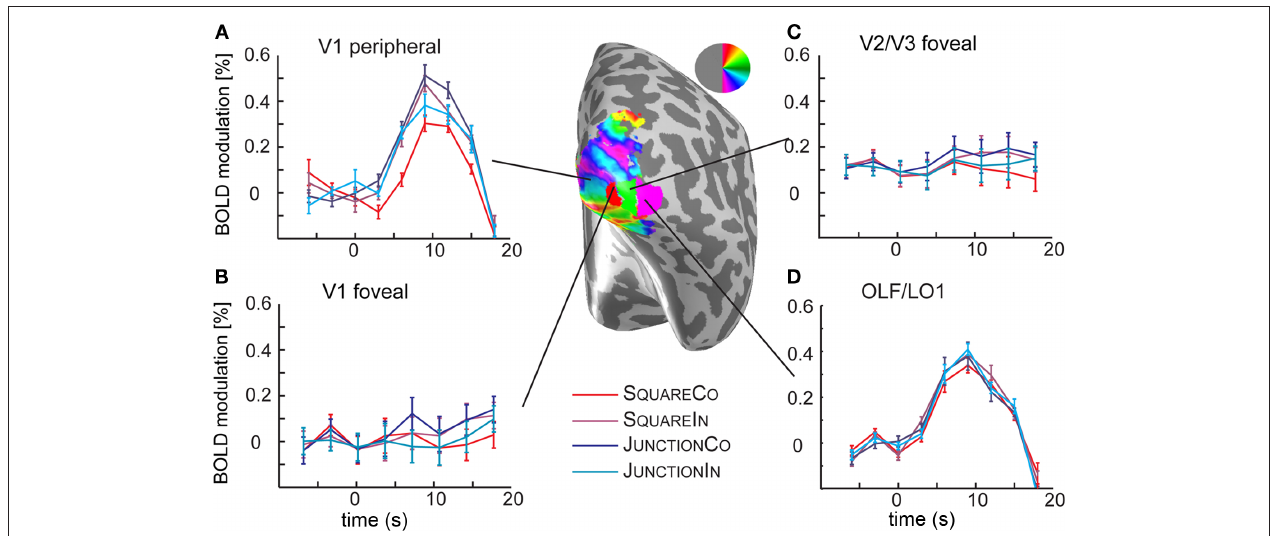
significant response to the stimuli. (C) In foveal V2/V3 the responses are similar to those in foveal V1. (D) Shows the time course in the OLF/LO1 ROI demonstrating a clear response to the stimulus presentation. Note however that the eccentricity maps on this region of cortex (not shown) mostly demonstrate